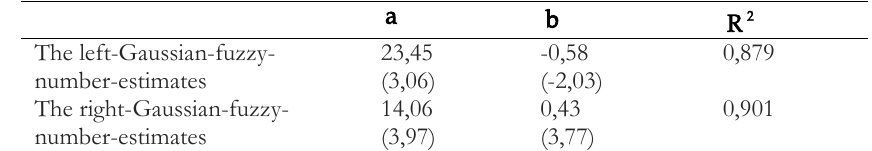
Table 1. Employment poverty relationship using the fuzzy numbers gaps square